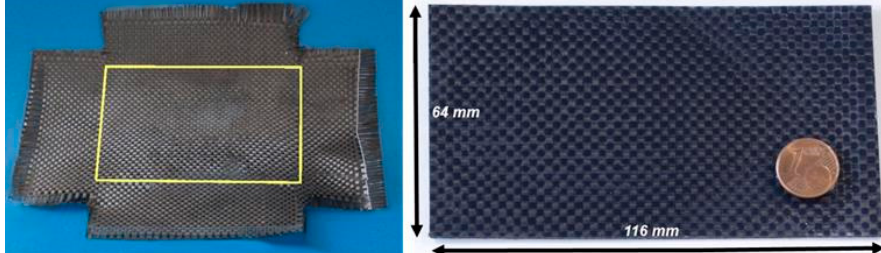
Figure 10. Raw carbon fiber canvas with marked welding area (left). Ultrasonically fabricated CFRP plate from three layers of carbon fiber canvas with a thickness of 300 µ m each and eight layers of PA film, each 100 µ m in thickness. The fabricated CFRP plate had outer dimensions 116 mm × 64 mm and the thickness was 1.2